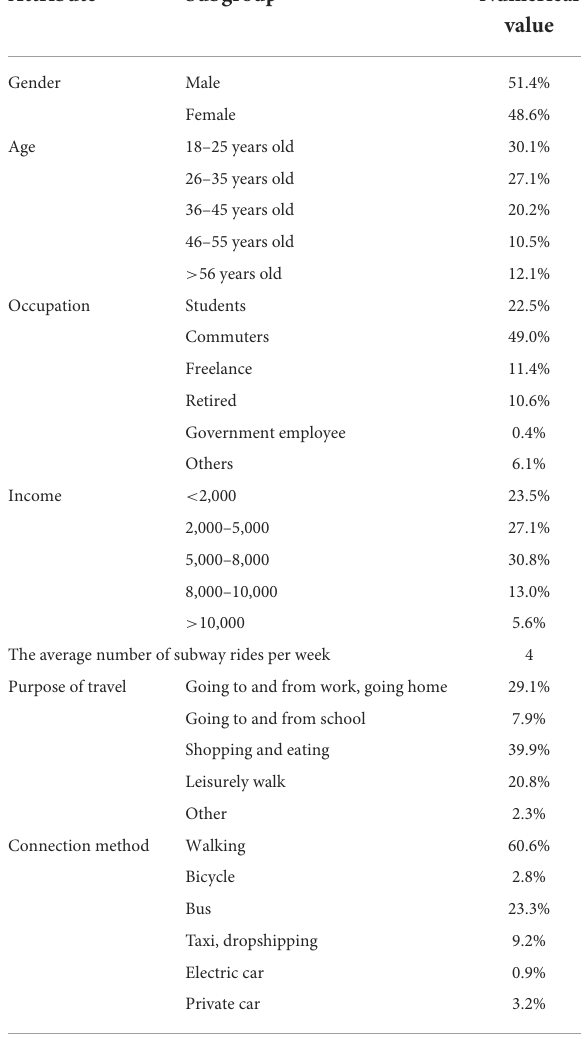
TABLE 3 Basic attributes statistics